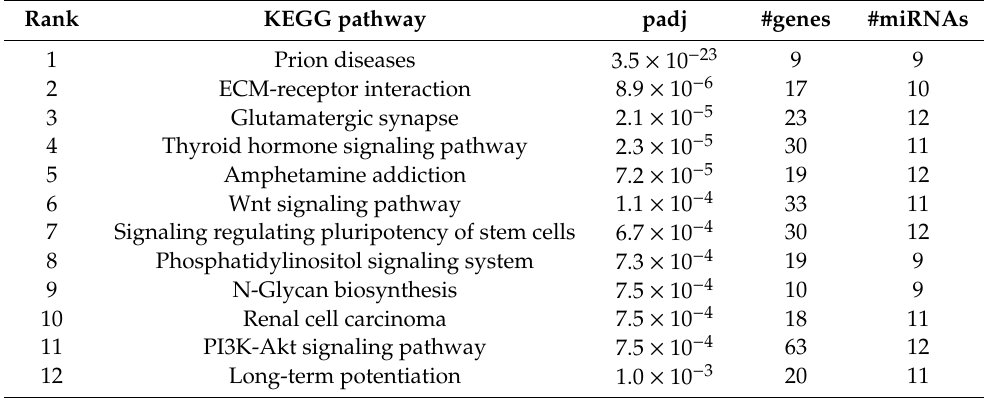
Table 3. KEGG pathways for the down-regulated miRNAs in clinical-stage Tg501 mice (padj < 0.001). Rank KEGG pathway padj #genes